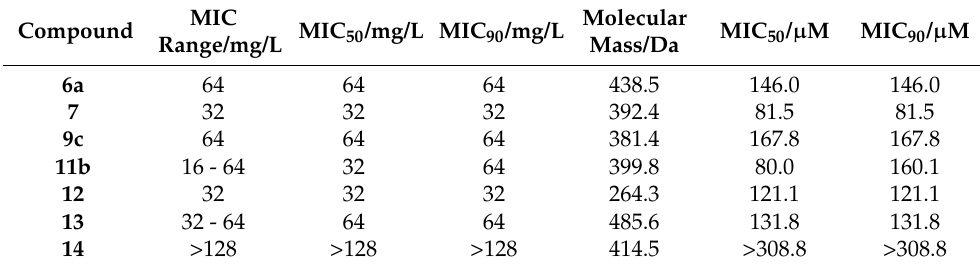
Table 7. Experimental MIC of the selected compounds against